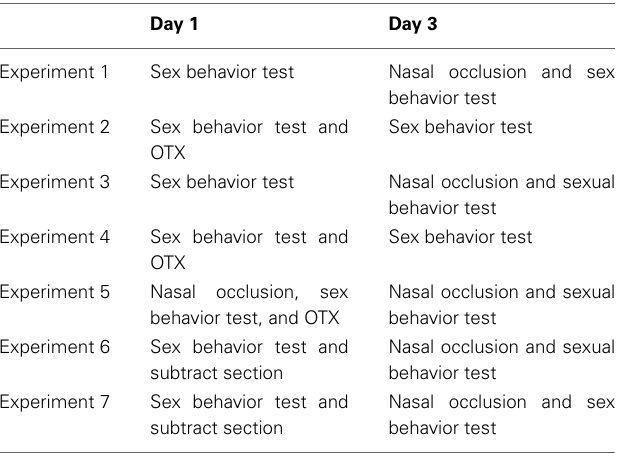
Table 1 | Experimental design of sexual behavior in